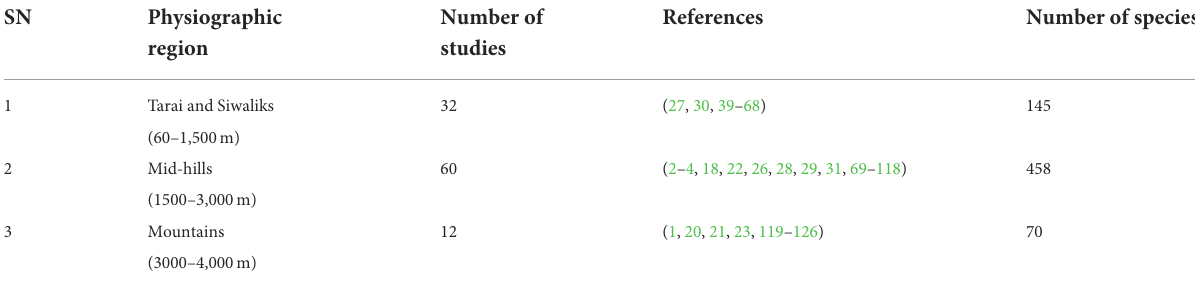
TABLE 2 Distribution of ethnoveterinary plant species in different physiographic regions of Nepal based on the literature.